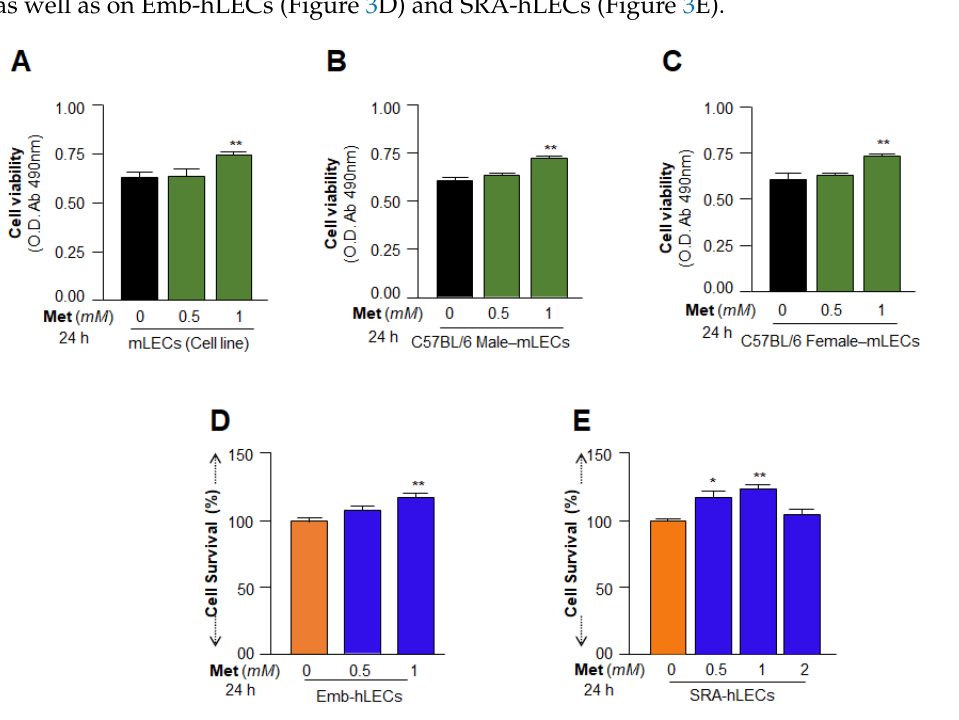
Figure 3. Metformin provided better cell growth of mouse and human LECs. Cell viability assay showing the concentration-dependent effects of Metformin on growth/health of LECs ( A ) mLECs line, primary mLECs isolated from C57BL/6 male ( B ), or female ( C ), Emb-hLECs ( D ) and SRA-hLECs ( E ). Cultured mouse and human LECs were treated with different concentrations of Metformin as shown in figure and were processed for MTS assay to determine nontoxic concentration of Metformin and its effect on cell growth/health. The histograms represent the mean ± S.D. from three independent experiments. Vehicle control vs. Metformin-treated; * p < 0.05; ** p < 0.001.